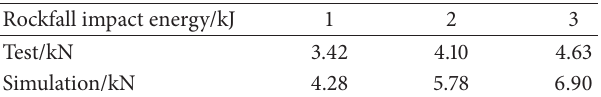
Table 3: The contrast of the average forces in the test and numerical simulation.